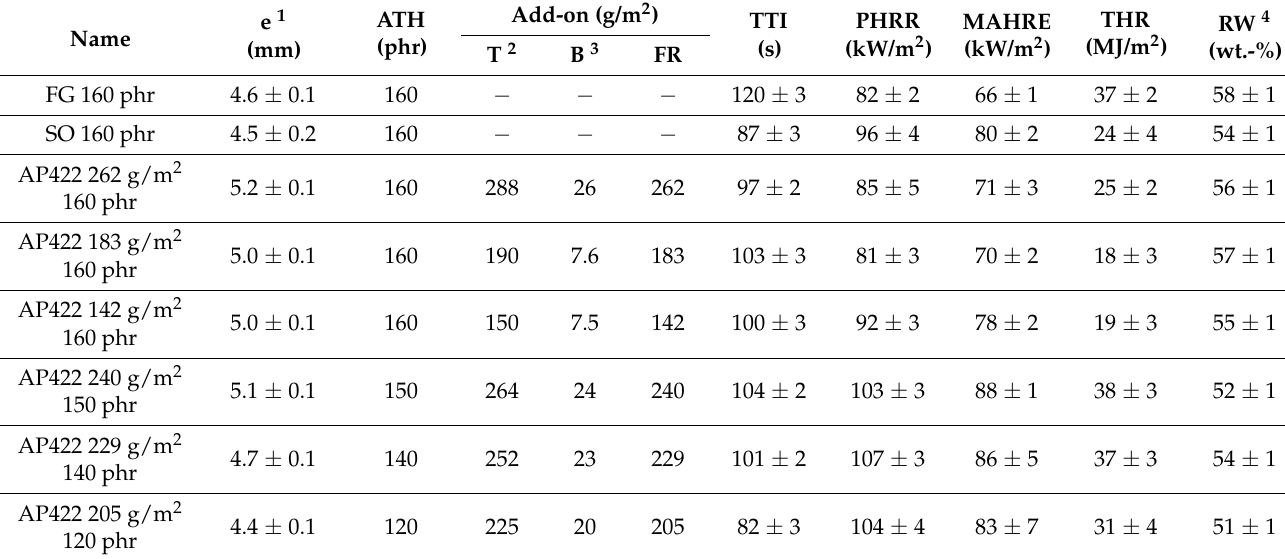
Table 3. Parameters extracted from the cone calorimeter data obtained for the different laminates.